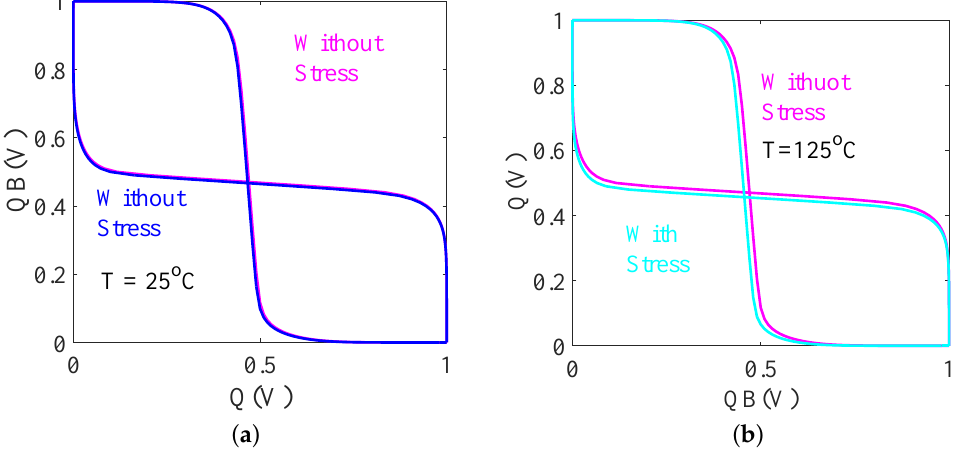
Figure 17. Degradation in SNM under 10 year NBTI stress at ( a ) T = 25 °C. ( b ) T = 125